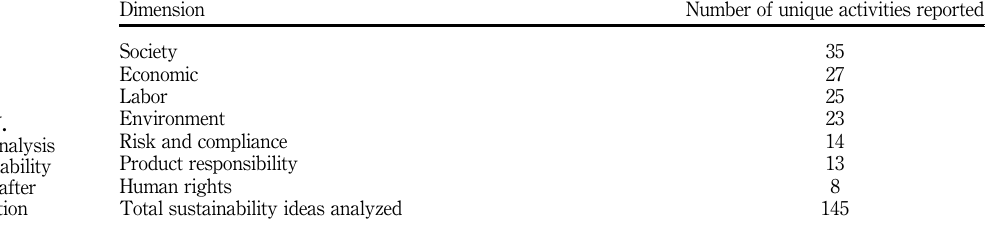
Table IV. Content analysis of sustainability activities after